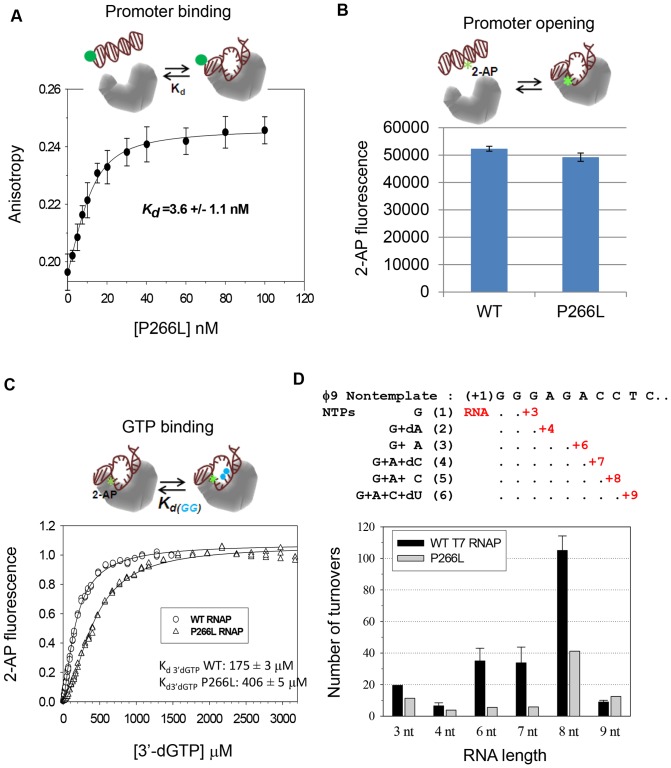
Promoter binding, opening, GTP binding and RNA turnover.(A) TAMRA fluorophore labeled promoter DNA (20 nM) was titrated with increasing P266L T7 RNAP (0 to 100 nM) and increase in fluorescence anisotropy was fit to the quadratic equation with K
d of 3.6±1.1 nM. Similar to the WT T7 RNAP, the P266L mutant did not cause significant changes in the TAMRA fluorescence intensity (<10%) upon binding. Effect of the intensity changes on the fitting was insignificant and corrected the same way as reported previously [23]. Shown here are averaged values with standard deviations (error bars) from multiple independent measurements, from which K
d was fitted. (B) The increase in 2-AP fluorescence at −4 in the template strand upon addition of WT and P266L indicate slightly lower promoter opening with P266L. The errors are standard deviation from 10–15 measurements. (C) Initiating GTP binding was monitored from fluorescence increase in the 2-AP (−4 position) labeled promoter DNA bound to T7 RNAP titrated with increasing 3′dGTP. The P266L binds to the initiating NTPs (3′dGTP) ∼2 times weaker than WT T7 RNAP (175 μM versus 405 μM) and Hill coefficients are 1.3±0.02 and 1.7±0.03 for WT and P266L, respectively. The errors represent the fitting uncertainty. (D) A complex of WT or P266L T7 RNAP (2 µM) and promoter DNA (1 µM) was mixed with limited NTPs or NTP and 3′-deoxy NTP mixture for 2 min at 25°C to allow RNA synthesis of the indicated lengths. The amount of RNA shown in µM is representative of the number of turnovers at each walked position for WT (black) and P266L (grey) T7 RNAP.